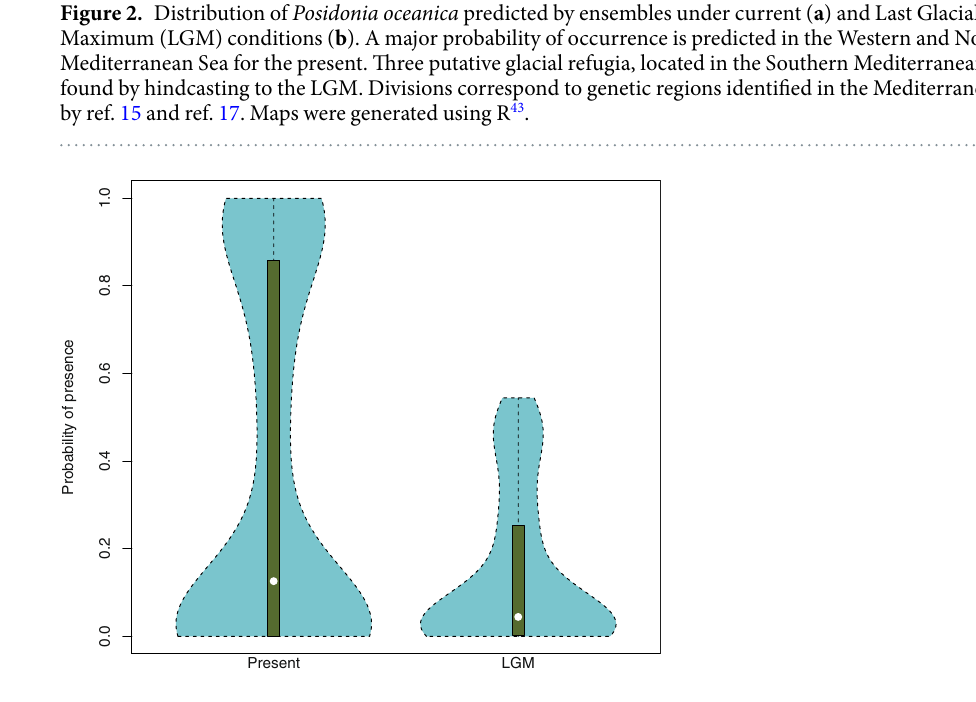
Figure 3. Distribution of probability of presence predicted for Posidonia oceanica under current and Last Glacial Maximum (LGM) conditions. Globally, climatic conditions in the Mediterranean Sea were less suitable for P. oceanica during the LGM than in the present. The white dot represents the median and the green bar represents the interquartile